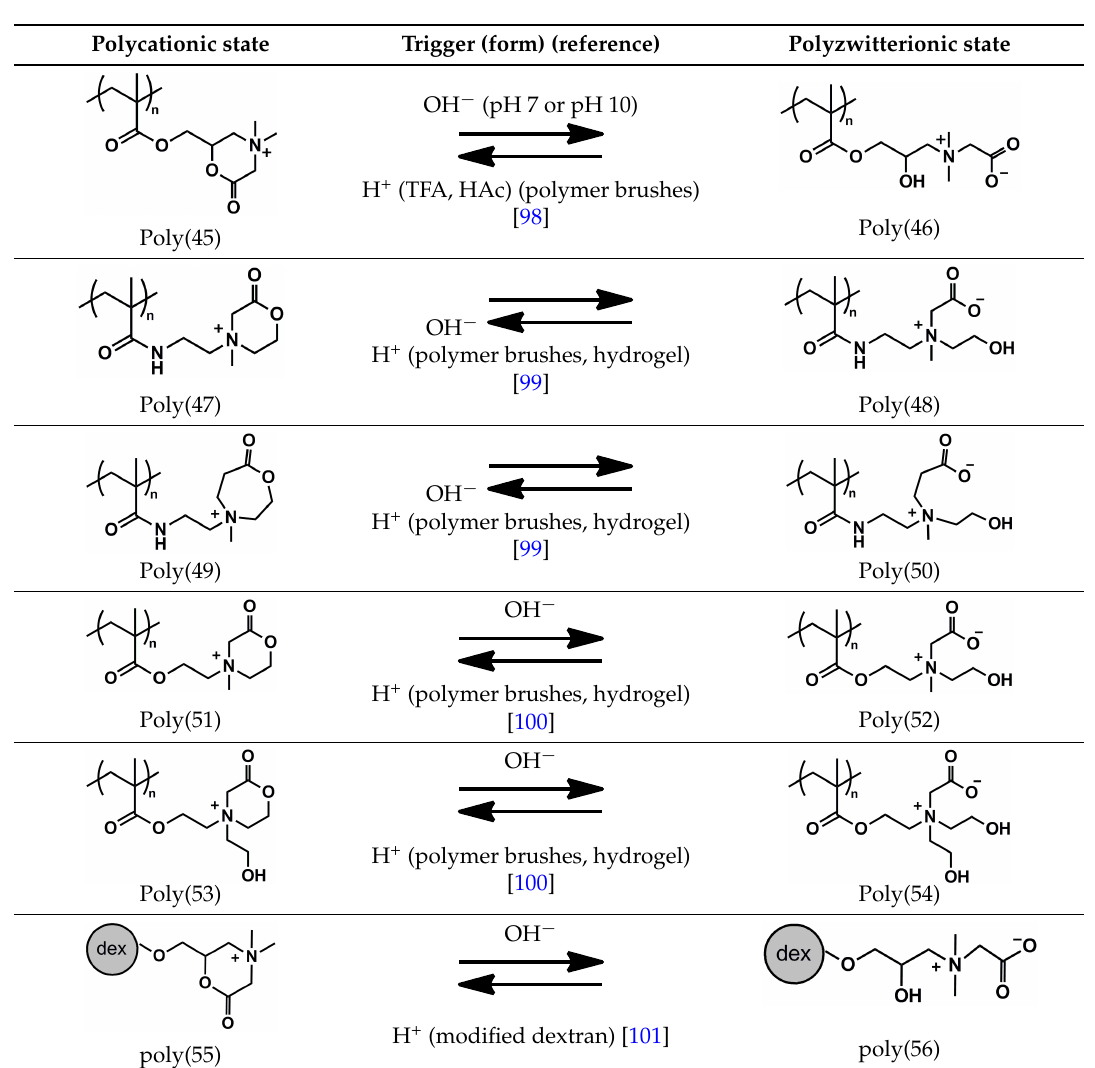
Table 6. Reversible switches containing polyzwitterionic